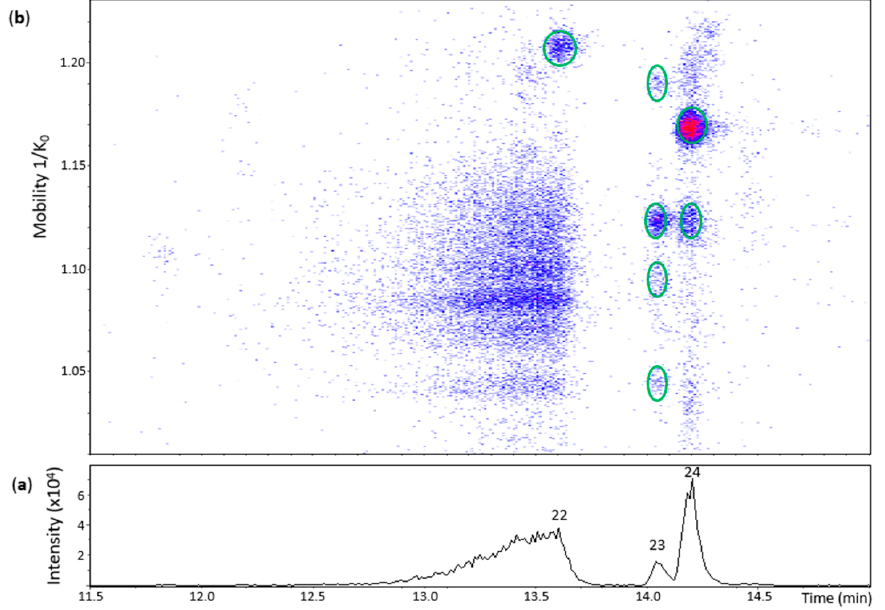
Figure 5. UHPLC − ESI ( − ) − TIMS − QTOF − MS/MS analysis of dehydrodicatechins in model solution containing ( − )-epicatechin and grape PPO extract. ( a ) EIC from the mass range of m / z 575.1–575.2. ( b ) Heat map showing the mobility versus Rt for the mass range of m / z 575.1–575.2. Full details on peak numbers are available in Table S2. Ellipses on the heat map mark the main spots.